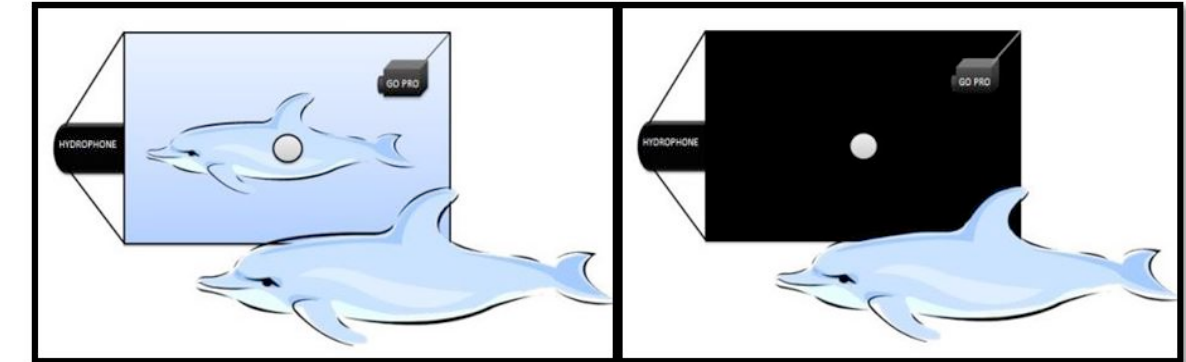
Figure 1. A diagram of the experimental apparatus (i.e., the “stimulus”) utilized to assess dolphin behavioral